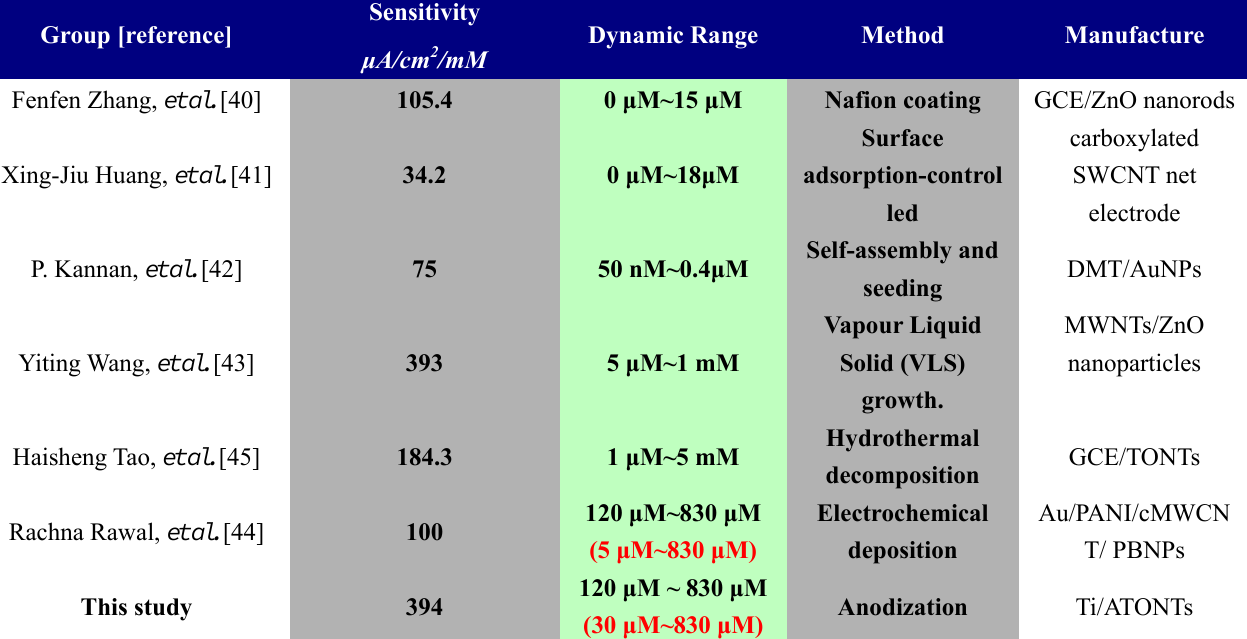
Table 2. Comparison of some uric acid biosensors based on nanostructures. Sensitivity Group [reference] Dynamic Range Method Manufacture μ A/cm 2 /mM Fenfen Zhang, et al. [40] GCE/ZnO nanorods